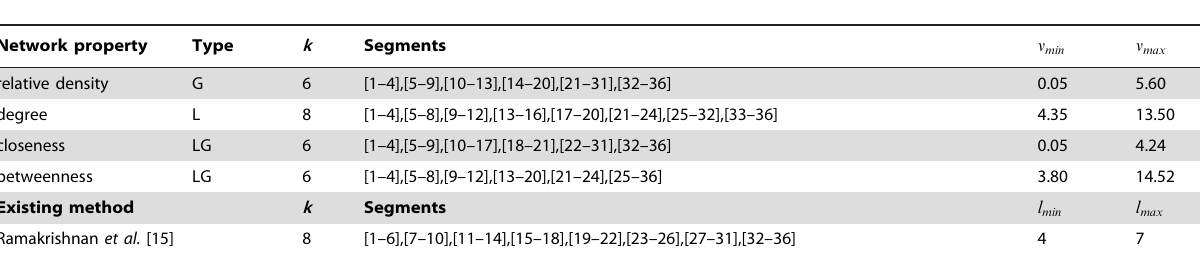
Table 2. Optimal segmentation for data from